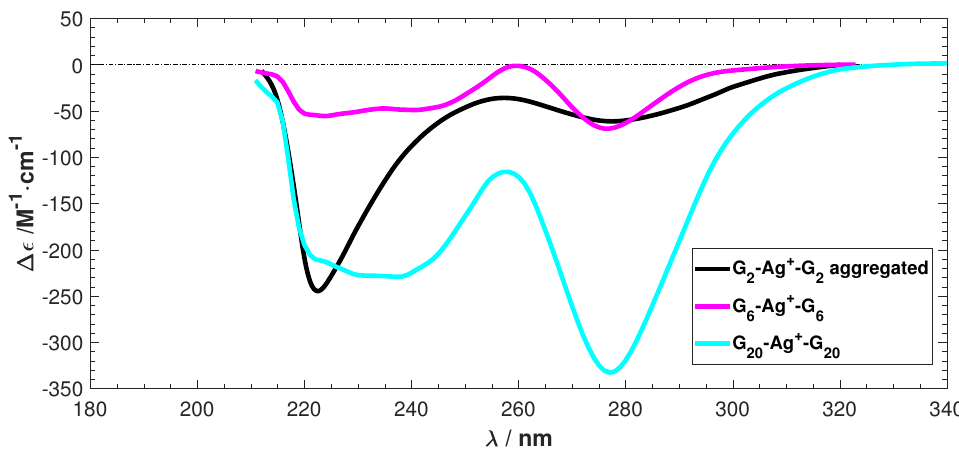
Figure 2. The experimental electronic circular dichroism (ECD) spectra of Ag + stabilized G 2 , G 6 , and G 20 . ∆ (cid:101) is differential molar extinction coefficients ∆ (cid:101) = (cid:101) L - (cid:101) R , λ is the wavelength. Data reproduced with permission from Swasey, S. and Gwinn, E. New J. Phys. 2016 , 18, 045008-045025.